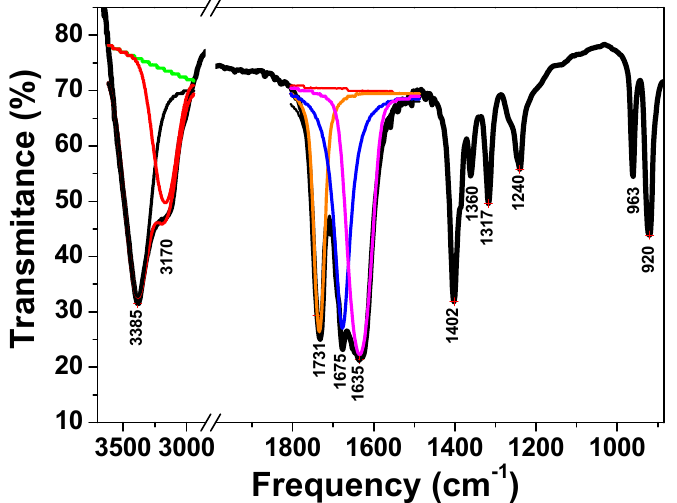
Figure 1. FTIR spectrum of the as-prepared oxalate precursor.